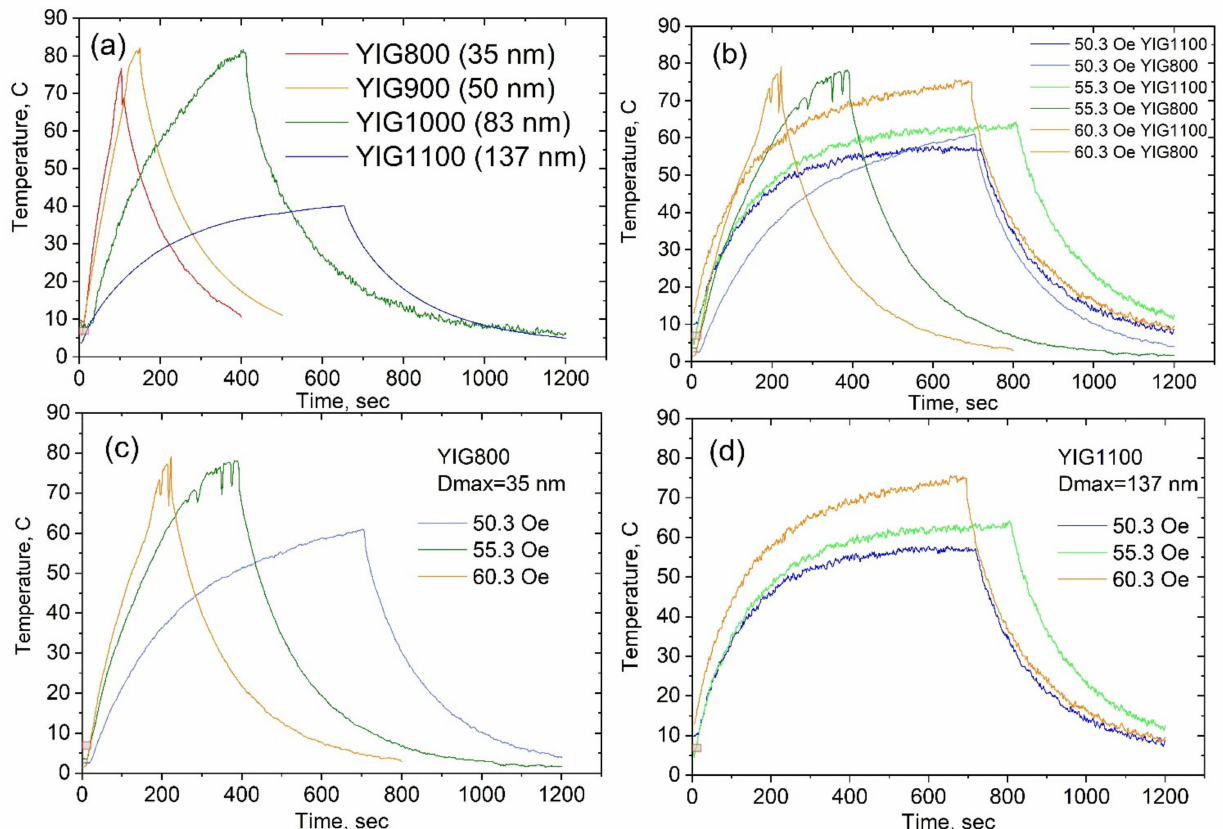
Figure 10. The particle temperature change at AC magnetic field with amplitude H = 70.4 Oe ( a ), the particle temperature change for two sizes (35 and 137 nm) at different H ( b ), the particle temperature change for YIG800 at different H ( c ), and the particle temperature change for YIG1100 at different H ( d ). Increasing—magnetic field switched on; decreasing—magnetic field switched off.